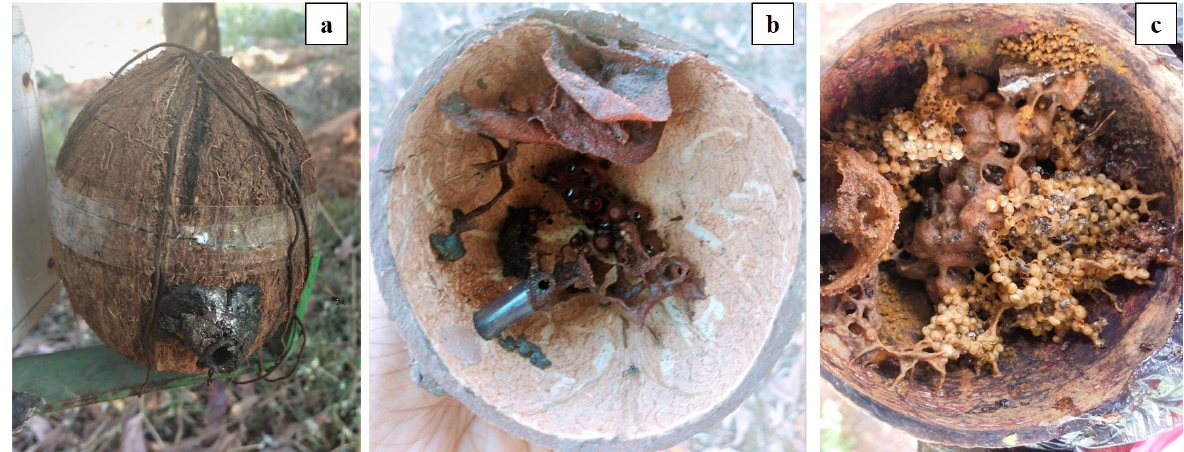
Fig 3a-c: Development of stingless bee colony in coconut shell. a. Foragers in the accepted coconut shell traps. b. Honey pots formed during the initial days of acceptance of shell traps. c. Fully established